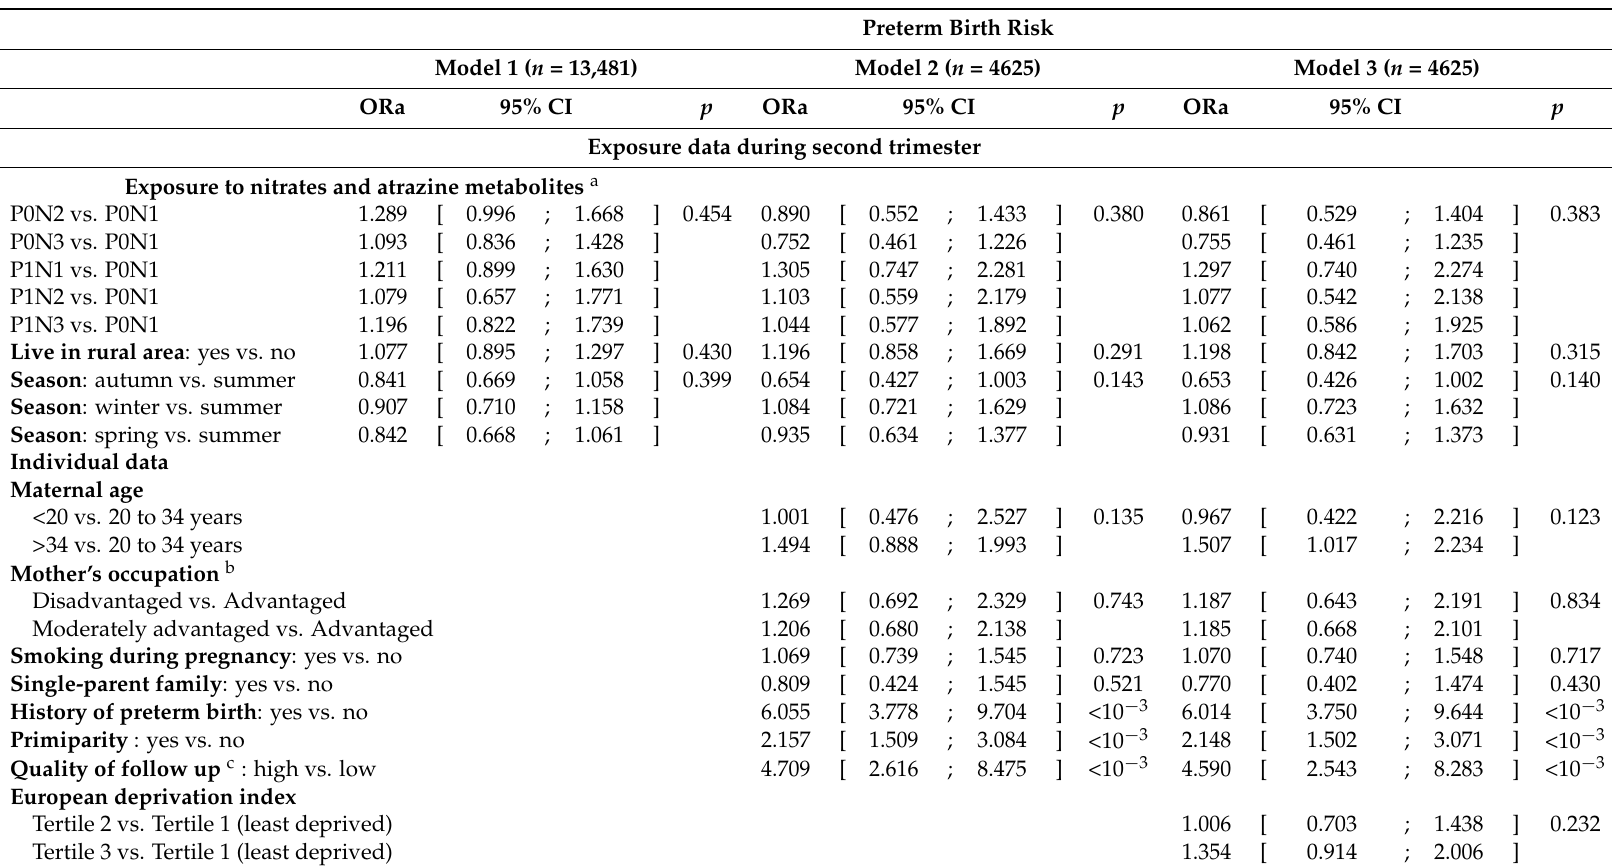
Table 5. Relation between exposure to nitrates/atrazine metabolite mixture in drinking-water and prevalence of preterm birth babies. Deux-Sèvres, France, 2005–2010, n = 4625 mother/neonate pairs and 277